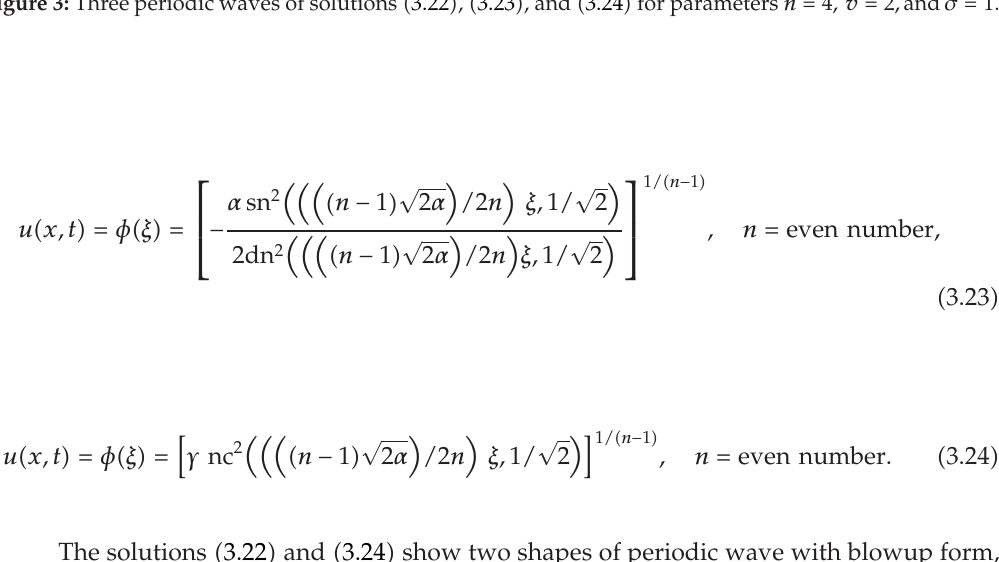
Figure 3: Three periodic waves of solutions (cid:2) 3.22 (cid:3) , (cid:2) 3.23 (cid:3) , and (cid:2) 3.24 (cid:3) for parameters n (cid:8) 4 , v (cid:8) 2 , and σ (cid:8) 1.